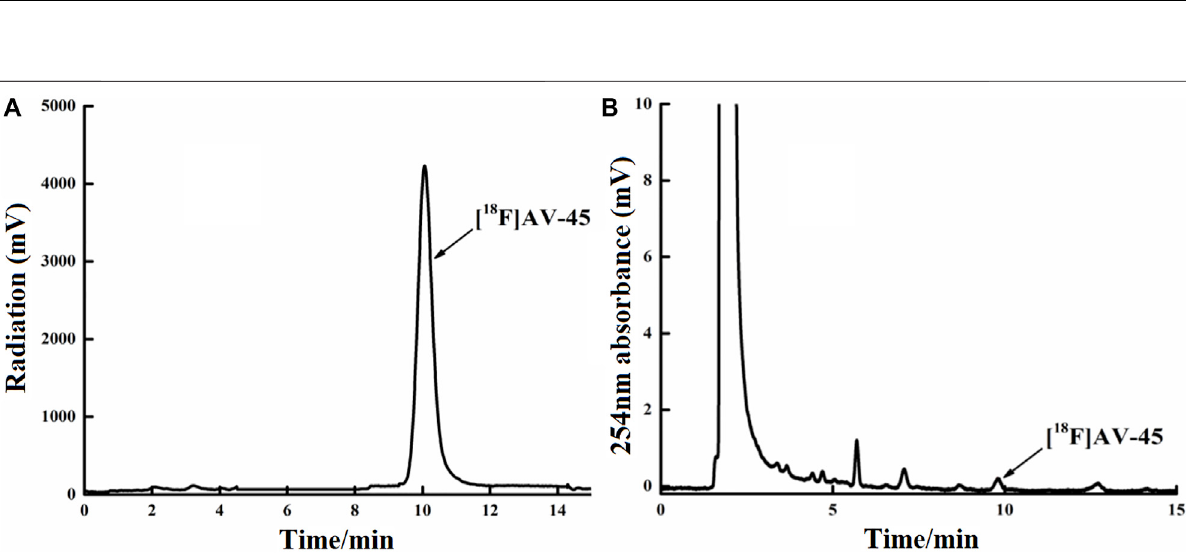
FIGURE5| Curveof[ 18 F]AV-45inpreparativeHPLCduringradiochemicalsynthesis. (A) Thesamplescurveobtainedbytheradioactivitydetector,inwhichthe fi rst peak isthe F − peak, and the second, larger peak isthe [ 18 F]AV-45 peak;the time to peak of[ 18 F]AV-45 isabout 24 min, similar tothe AV-45 standard. (B) The samples curve obtained by the ultraviolet detector, and the [ 18 F] AV-45 peak, indicated by the arrow, is very small.